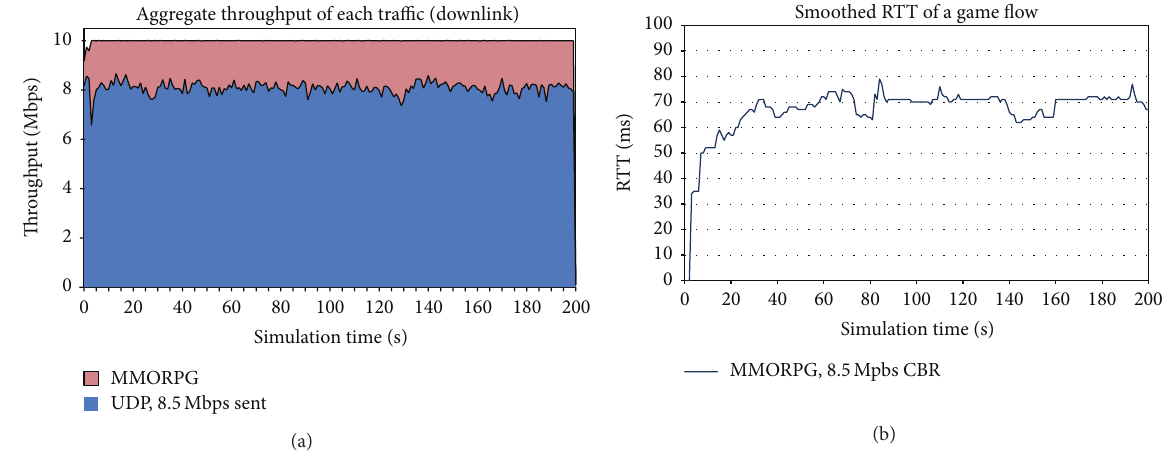
Figure 13: Coexistence of 100 MMORPG flows and 8.5 Mbps of UDP CBR traffic: (a) received throughput in the downlink by each traffic and (b) smoothed RTT of one of the game